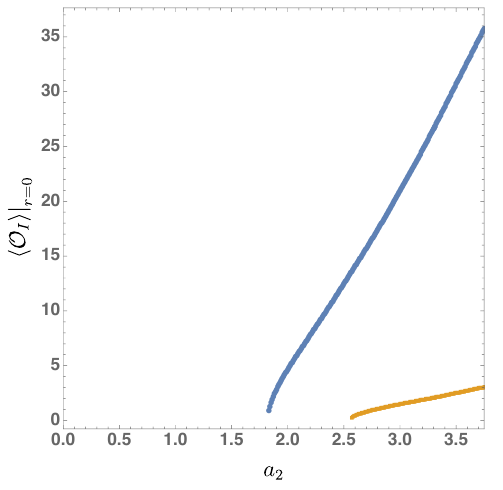
p 3 and q 2 = 4. The blue disks . r =0